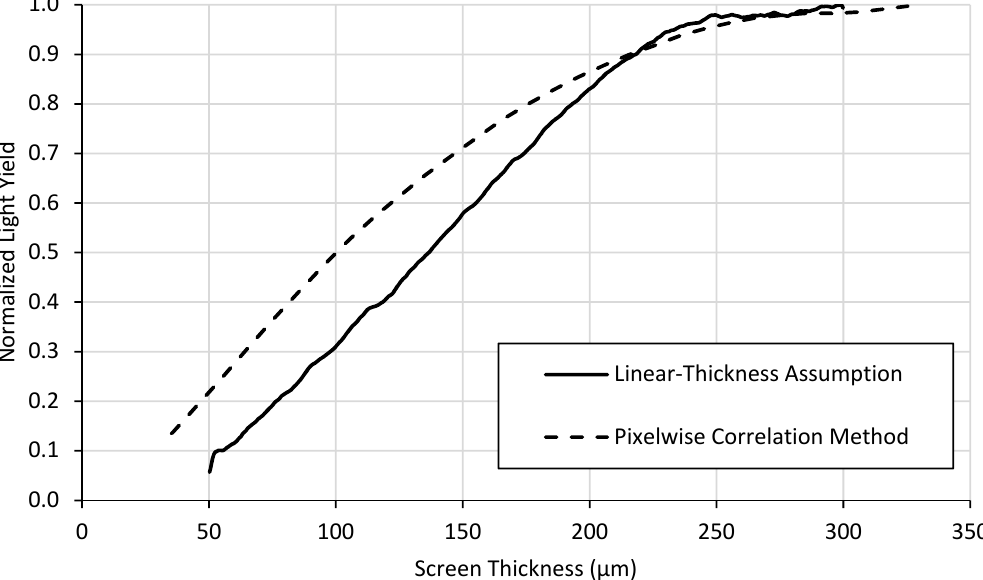
Figure 7. Light output as a function of thickness calculated using the two different methods for a 6 LiF:ZnS test-screen.